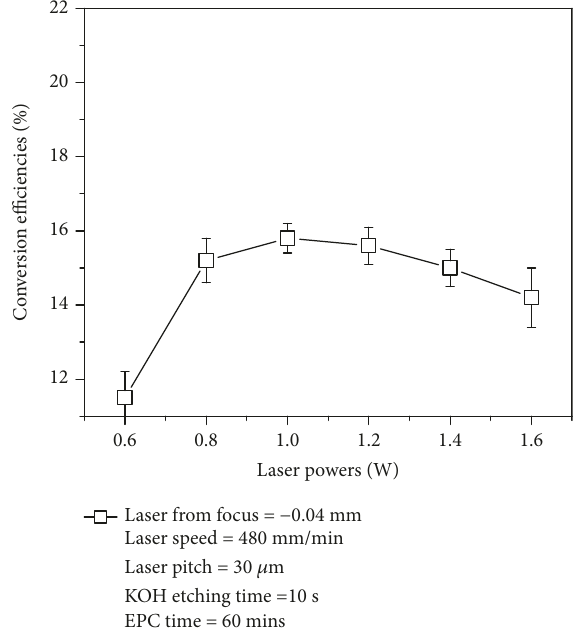
Figure 2: Conversion e ffi ciency vs. laser power curve of SPMSCs with a B-BSF seed layer and EPC contact layer as the rear